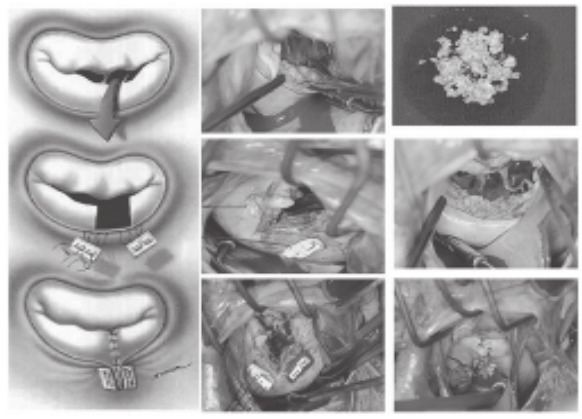
Fig. 1 - Ressecção quadrangular: técnica de duplo Teflon